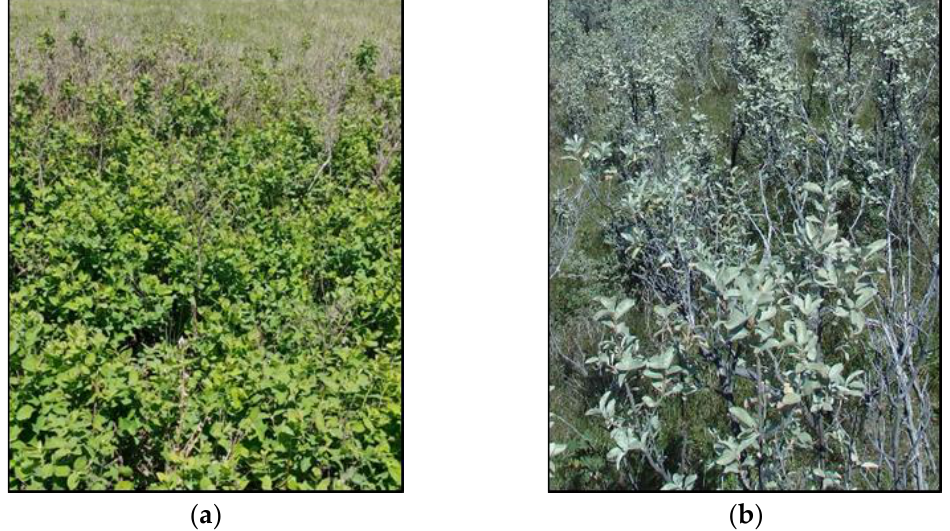
Figure 2. Shrub species present in study area: ( a ) western snowberry (source: personal collection, Kernen Prairie, Saskatoon, Saskatchewan, CA, 11 June 2020), ( b ) wolfwillow (source: personal collection, Cypress Hills Interprovincial Park, Saskatchewan, CA, 18 August 2020).